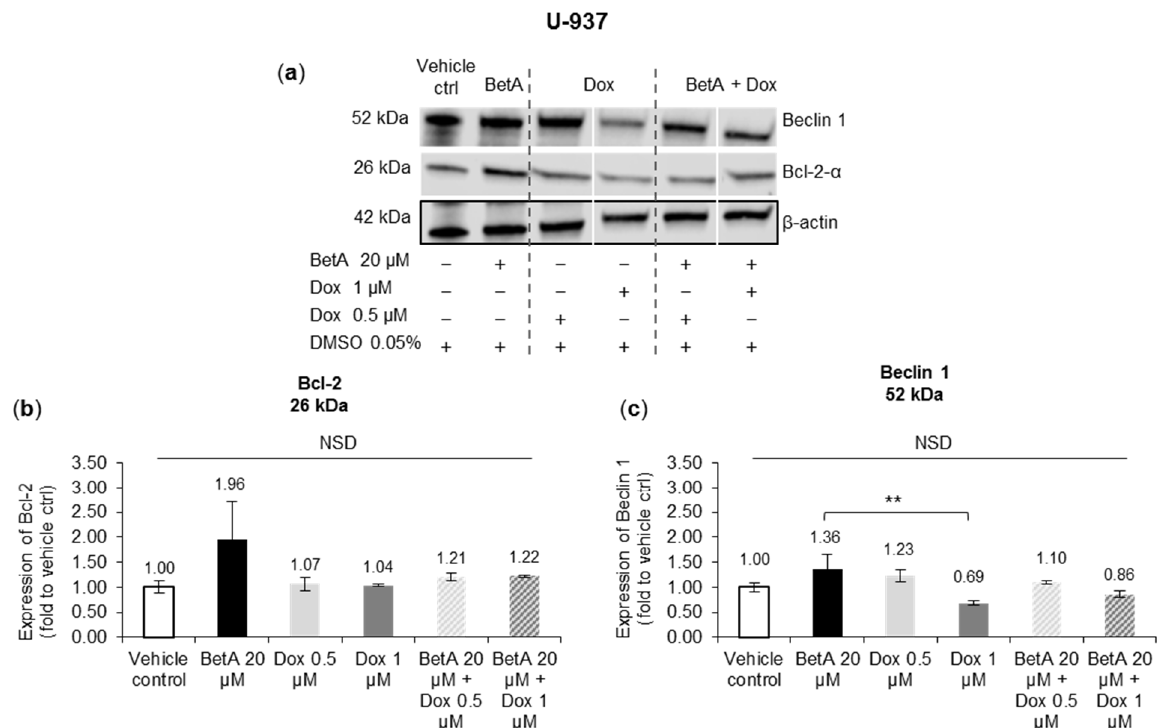
Figure 5. Apoptosis and autophagy regulating proteins expression in U-937 monocytes treated by single and combination drug. Leukaemic cell line U-937 cells were treated by single Dox or combination of BetA and Dox for 48 h. The protein expressions of autophagy marker Beclin 1 (52 kDa) and anti-apoptotic Bcl-2 (26 kDa) were estimated by Western blot ( a ). Experimental samples were run on the same gel and shown protein expressions are on the same blot for each protein antibody. Bcl-2 ( b ) and Beclin 1 ( c ) protein levels were determined by normalising quantified protein intensity relative to vehicle control (DMSO 0.05%, represented as 1.00-fold) and ratio between normalised data and β -actin (housekeeping protein). Data were expressed as mean + SE ( n = 3) and analysed by one-way ANOVA; Tukey post-hoc test. Statistical difference was accepted as following: p > 0.05 no significant difference (NSD), ** p ≤ 0.01 highly